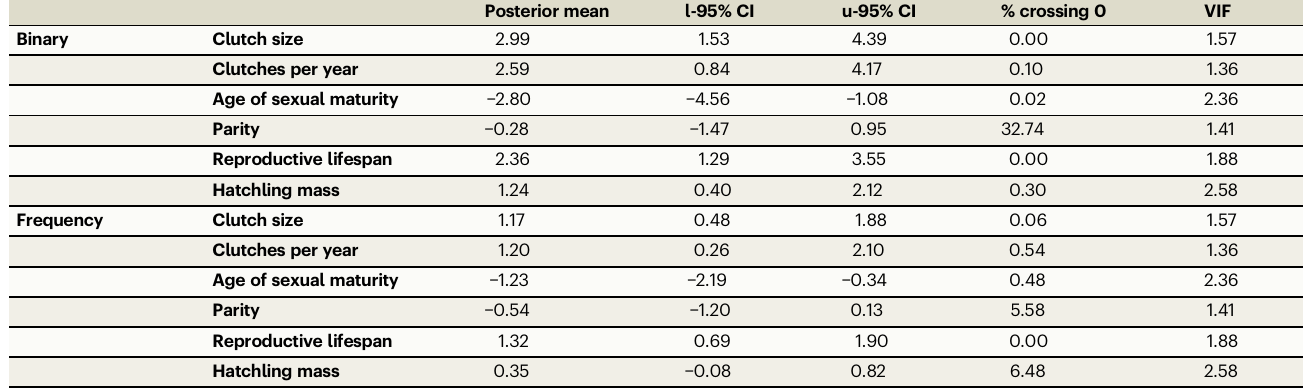
Table 3 | Life history predictors of US live wildlife trade probability and frequency in reptiles from hurdle models Posterior mean